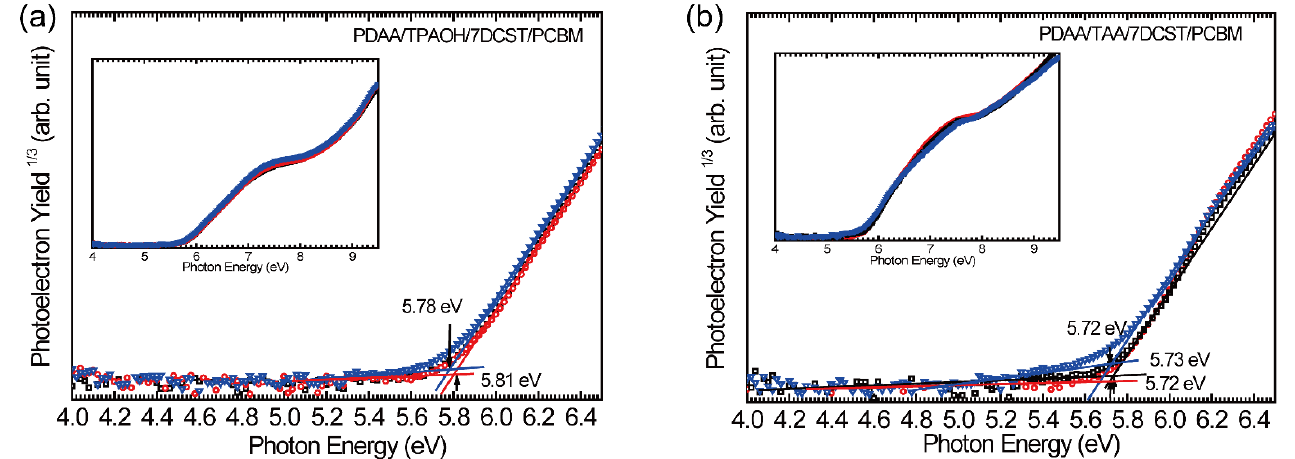
Figure 3. Plots of photoelectron yield as a function of incidence photon energy ( a ) for PDAA/TPAOH/7-DCST/PCBM and ( b ) for PDAA/TAA/7-DCST/PCBM. Three times measurements were performed at different illumination positions for each sample. Each measurement is separately shown by black, red, and blue plots. Black arrows and numerals indicate the ionization potential for each sample.